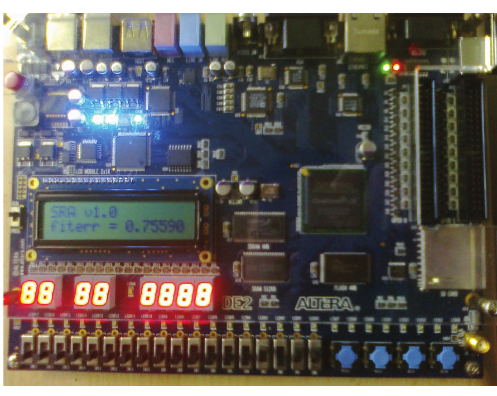
Figure 9: An illustration of SRA recovery solution when executed on an FPGA.